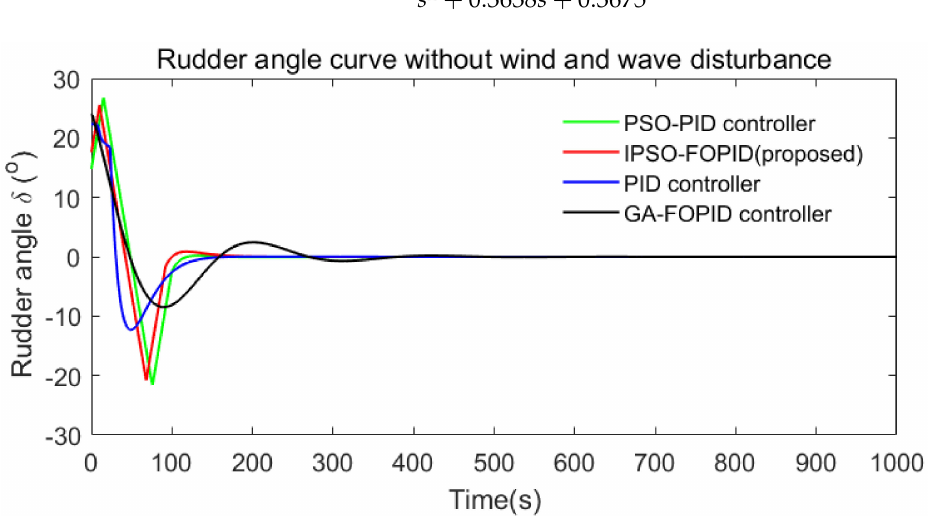
Figure 15. Rudder angle curves without disturbance.